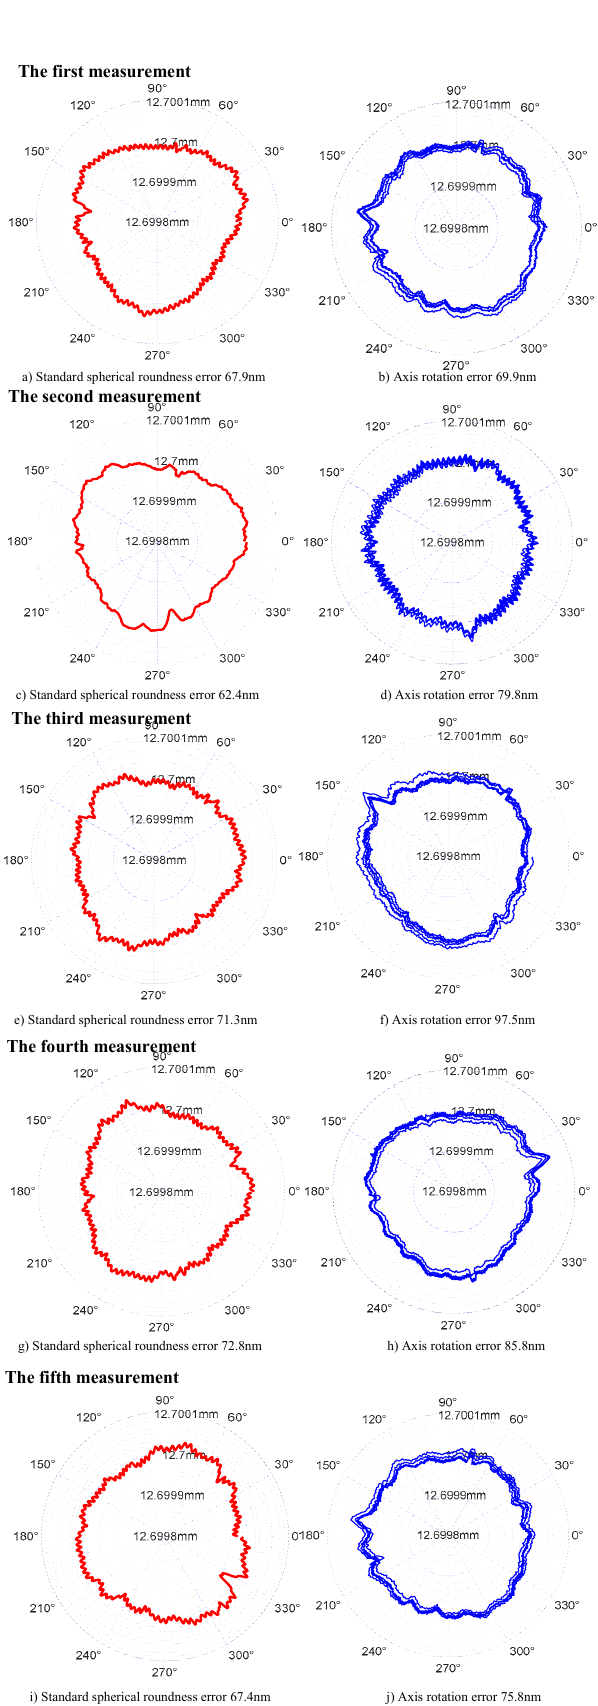
Figure 14. Repeatability test results of measurement system.